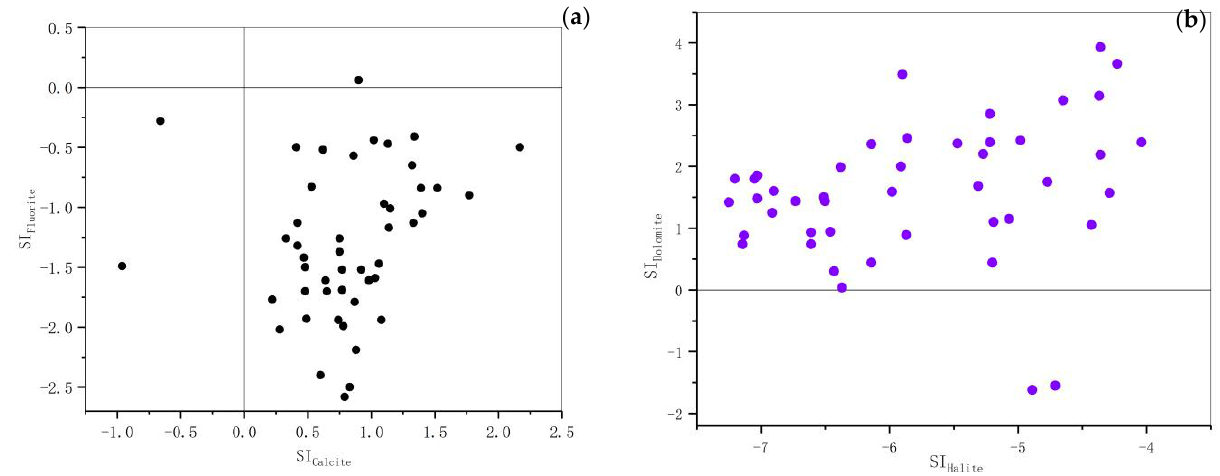
Figure 8. Diagram of the relationship between calcite and fluorite ( a ) and the relationship between dolomite and halite ( b ) in the groundwater.